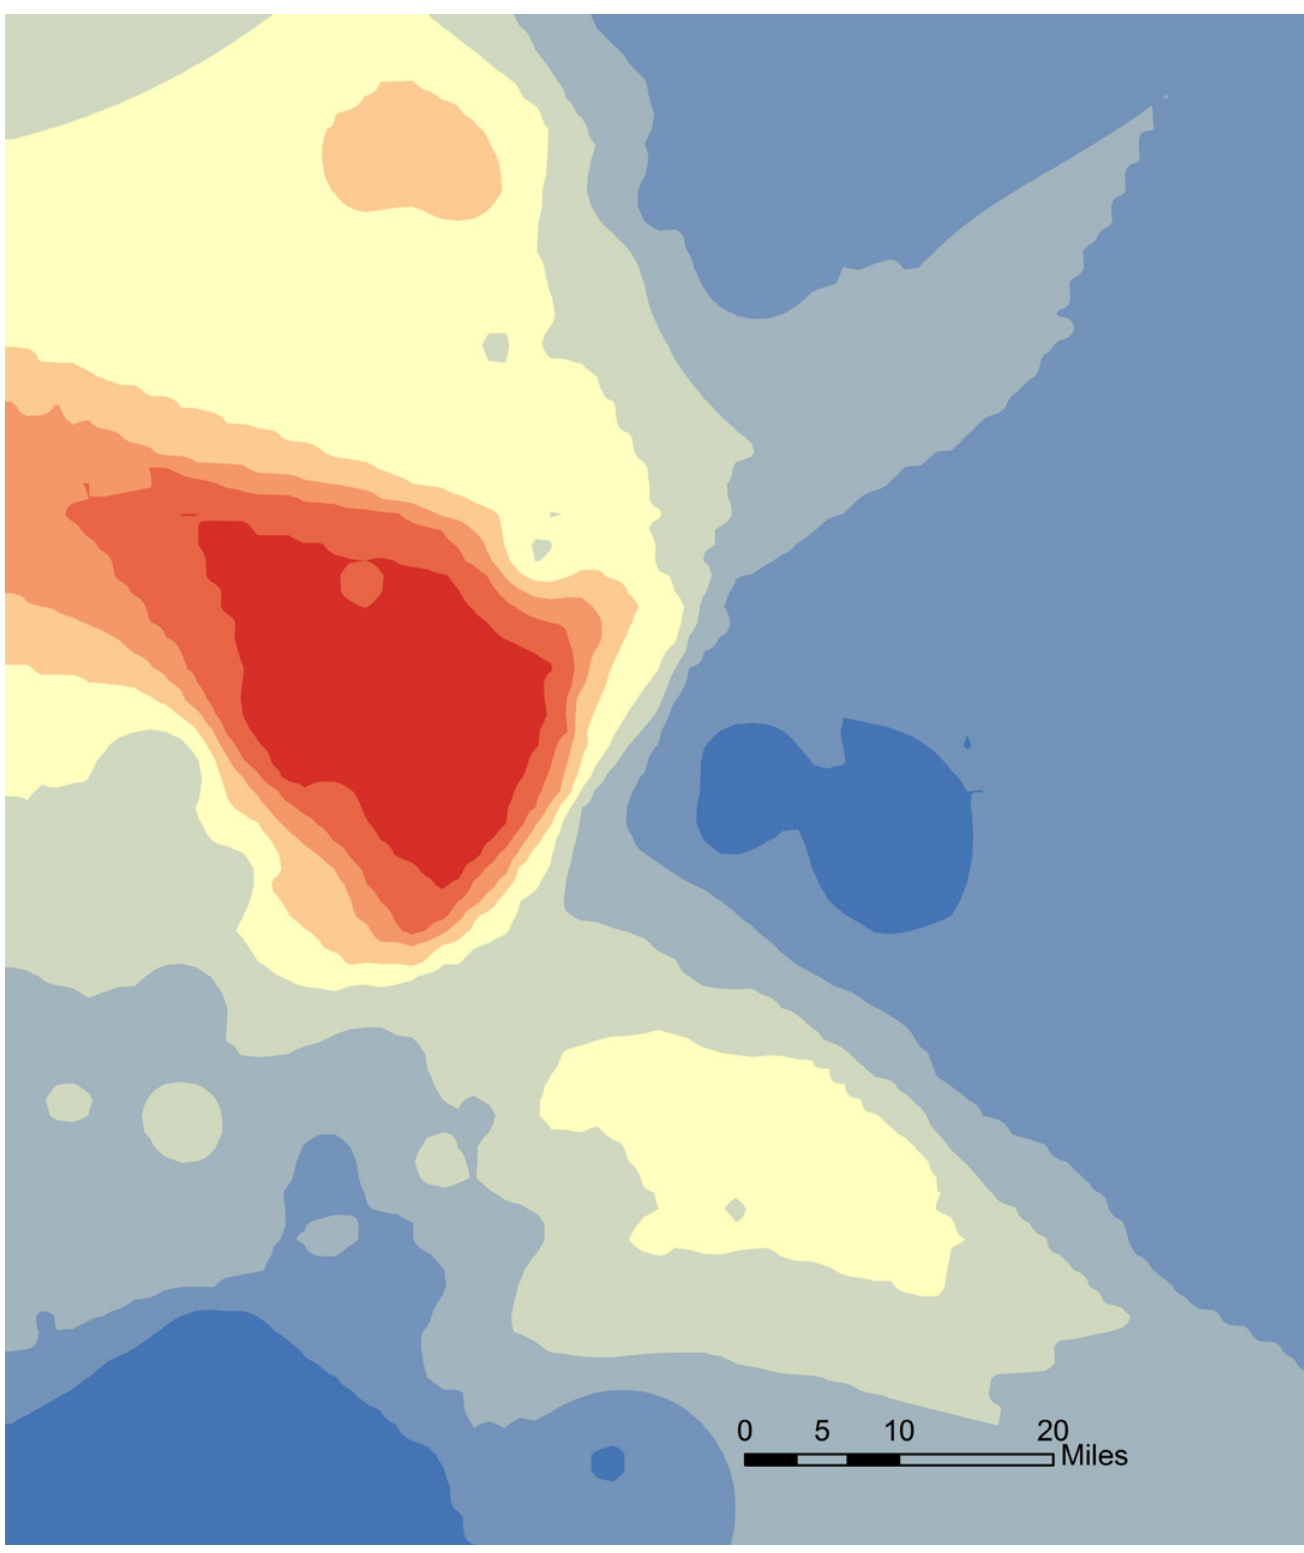
Fig 3. Hotspot cluster analysis of a Spring 2013 porcine epidemic diarrhea virus (PEDv) outbreak in 4 contiguous U.S. States. The red shades show the core cluster, which measured about 33 miles in the north-south direction and 41 miles in the west-east direction. doi:10.1371/journal.pone.0144818.g003 PLOS ONE | DOI:10.1371/journal.pone.0144818 December 28,